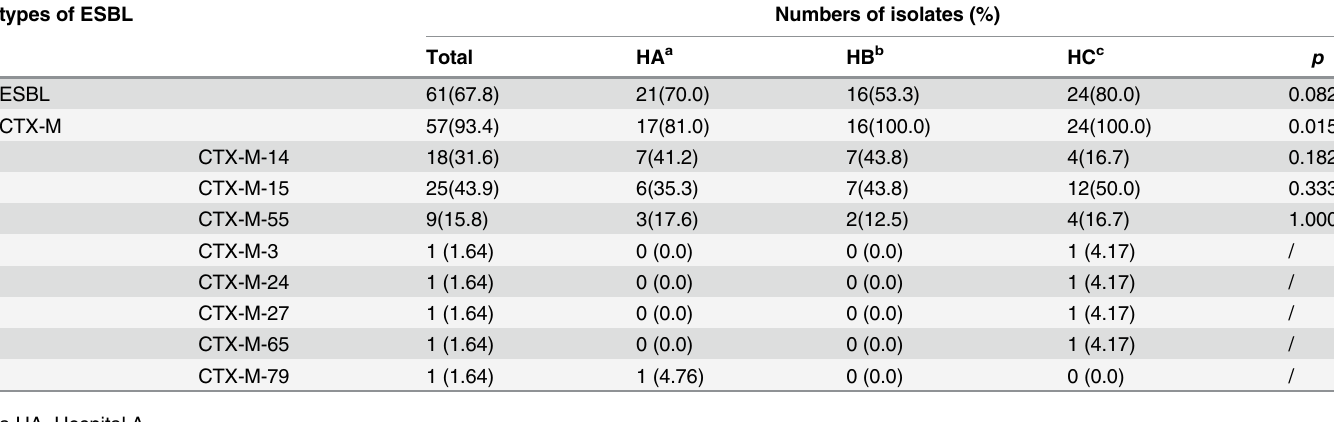
Table 3. ESBLGenes inSixty-one ESBL positive E . coli isolates from Bloodstream Infections withinThree